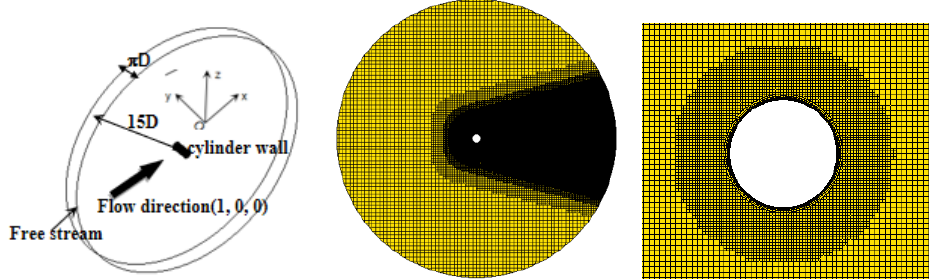
Figure 8. Circular cylinder model domain and discretization.